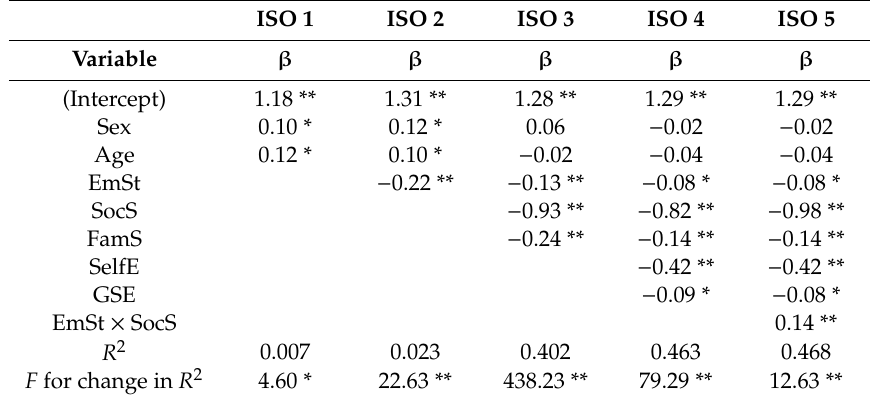
Table 6. Summary of nested regression analysis for variables predicting stress resulting from internal demands: stress due to social isolation (ISO) ( N = 1390).